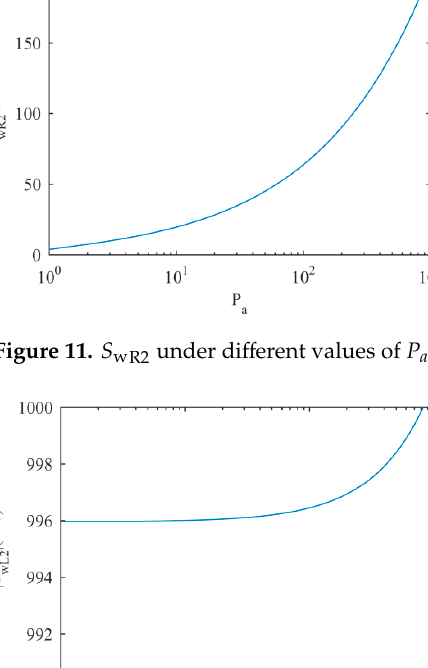
Figure 12. | S wL2 | under different values of P a .